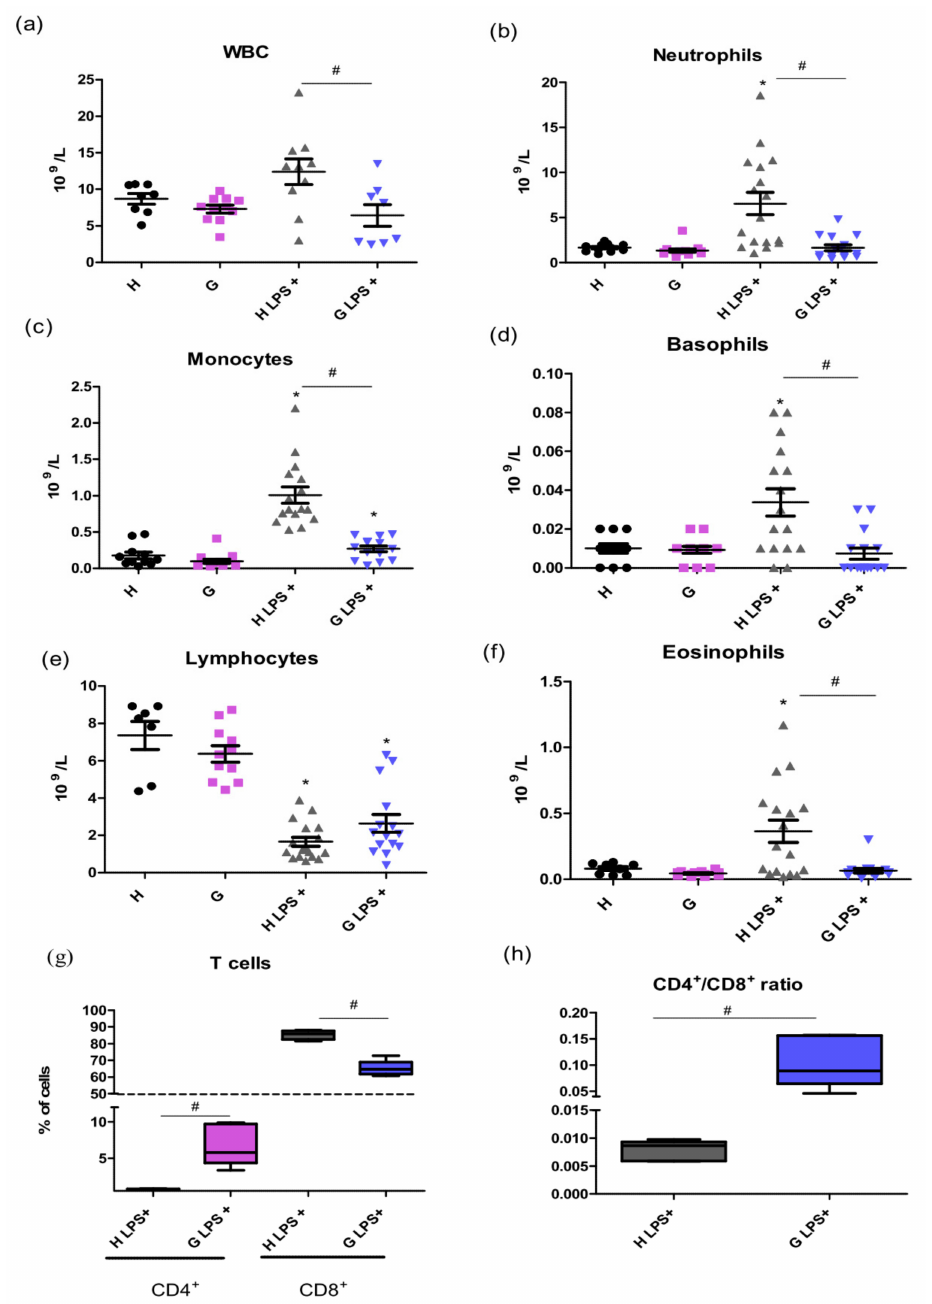
Figure 1. The e ff ect of LPS-induced inflammation on WBC in hyperbilirubinemic Gunn rats. Total WBC cells ( a ) and their subpopulations ( b – f ) including T cells count ( g ) and CD4 + / CD8 + ratio ( h ) were measured 12 h after LPS administration (6 mg / kg i.p.) in normobilirubinemic heterozygous controls (H or H LPS + ) and hyperbilirubinemic Gunn rats (G or G LPS + ), respectively. * p < 0.05 vs. corresponding control, # p < 0.05 vs. LPS-treated group. n = 8 animals per group